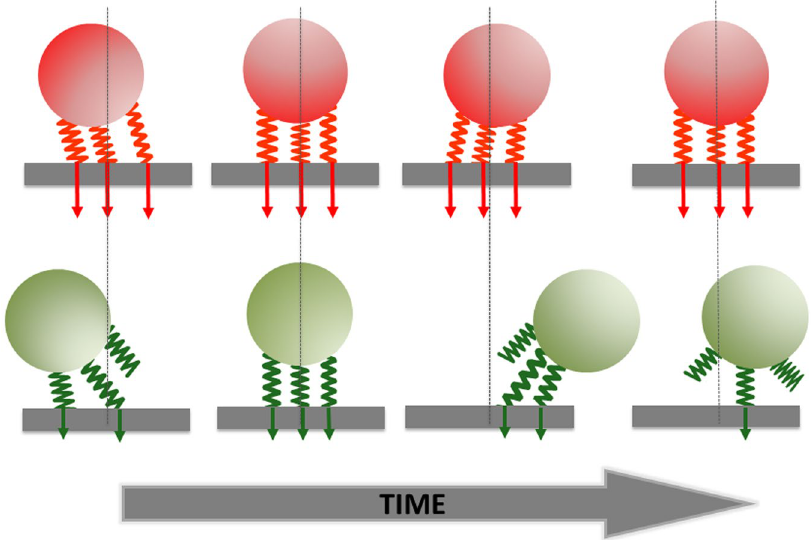
Figure 5. Proposed mechanism of the irreversibility of bacterial adhesion due to multiple, reversibly binding tethers as derived from the influence of adhesion forces on the vibration amplitude and confined Brownian- motion of adhering bacteria and supported by in silico simulations: Strong adhesion forces (red panel) of individual tethers impede Brownian-motion induced detachment of tethers resulting in small vibration amplitudes, while small adhesion forces (green panel) allow detachment of tethers resulting in larger vibration amplitudes and nanoscopic displacement parallel to the surface when re-attaching at a different